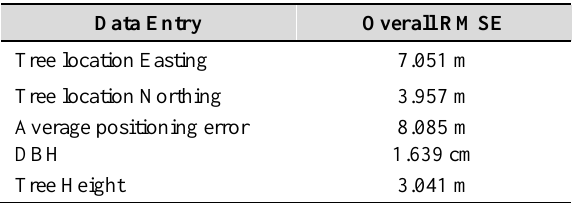
Table 1. Overall RMSE in tree inventory of task 1